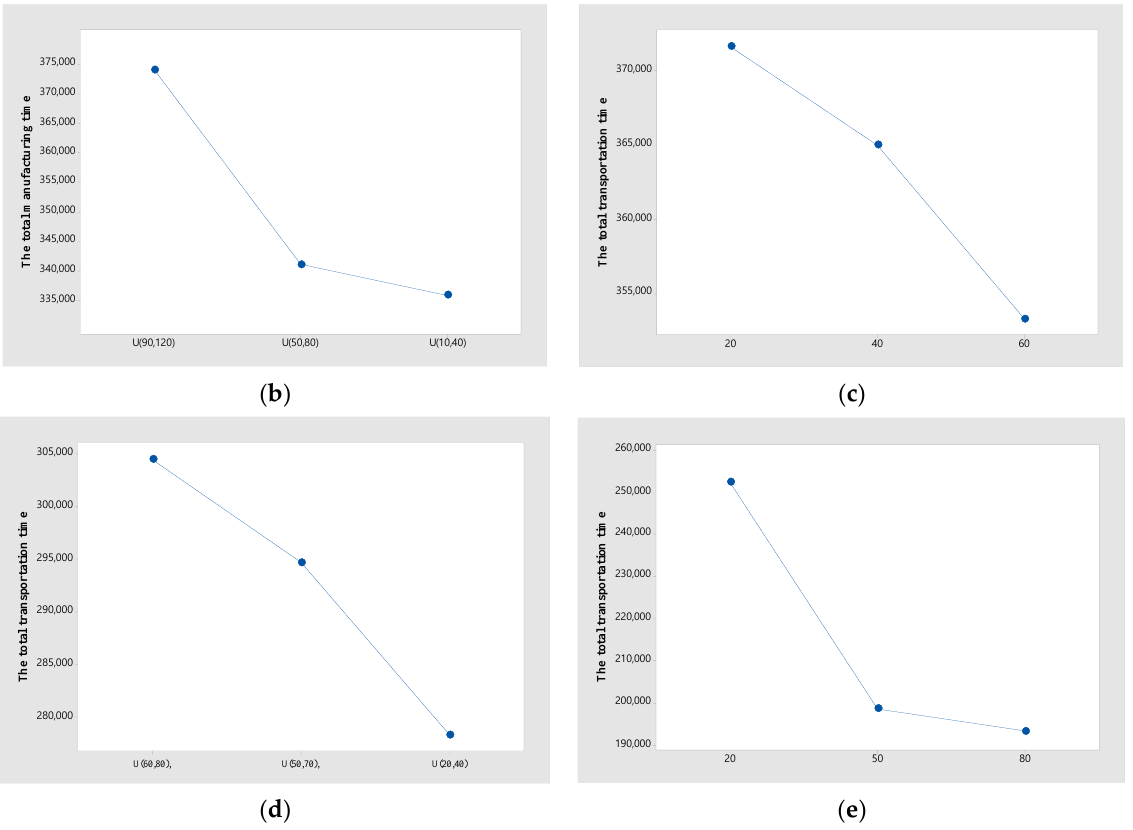
Figure 8. Total manufacturing and delivery time under different |𝑇| , ℎ 𝑐 , 𝑉 𝑇 , 𝑝 𝑓 , and 𝑉 𝑀 . ( a ) Total manufacturing time under different |𝑇| . ( b ) Total manufacturing time under different ℎ 𝑐 . ( c ) Total manufacturing time under different 𝑉 𝑇 . ( d ) Total delivery time under different 𝑝 𝑓 . ( e ) Total delivery time under different 𝑉 𝑀 .